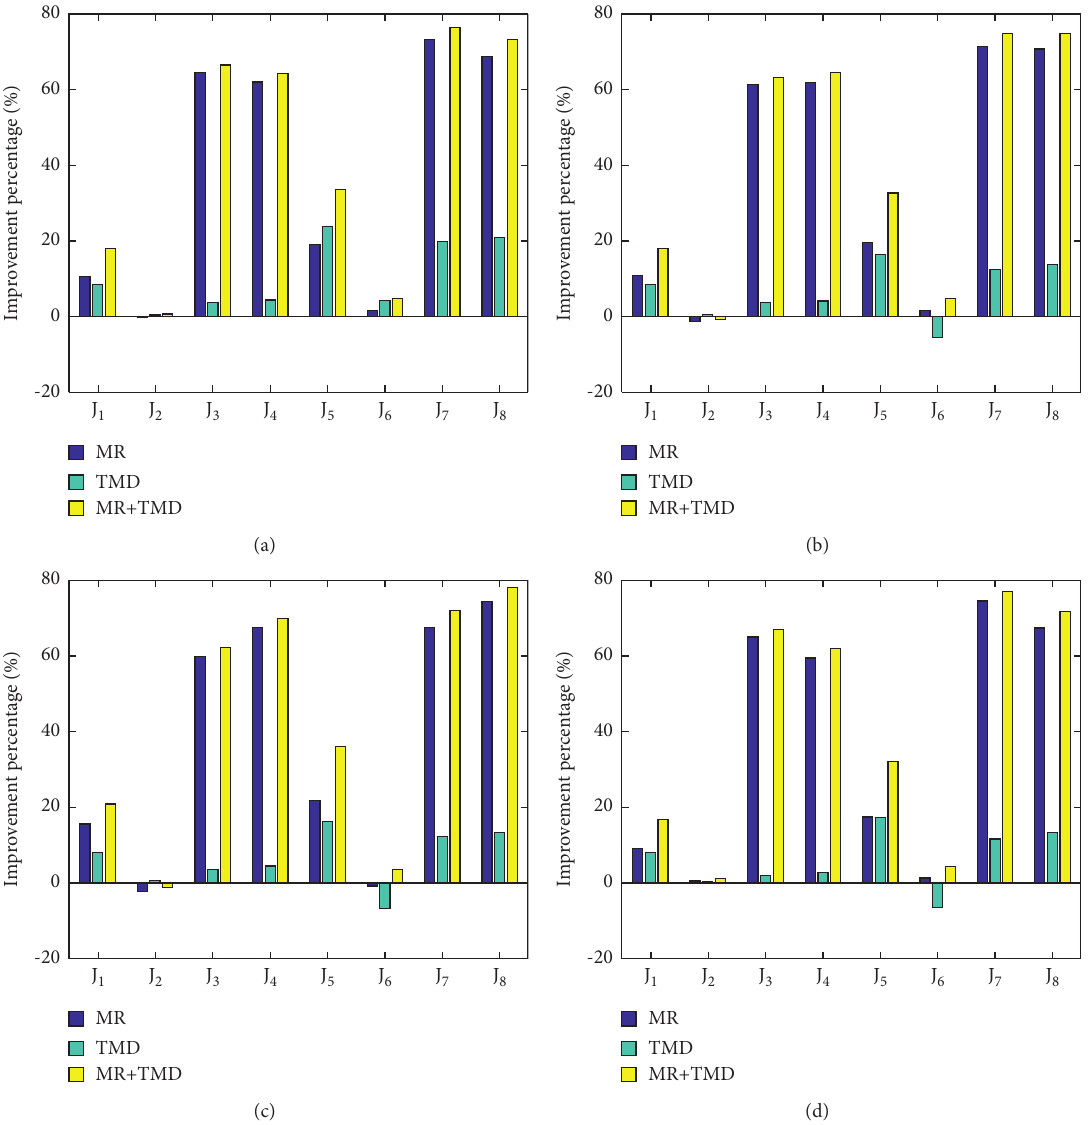
Figure 5: Average percentage of improvement in performance criteria: (a) the regular structure subjected to far-field earthquakes, (b) stiffness irregularity in the 1st-5th stories of structure subjected to far-field earthquakes, (c) stiffness irregularity in the 1st story of structure subjected to far-field earthquakes, (d) stiffness irregularity in the 5th story of structure subjected to far-field